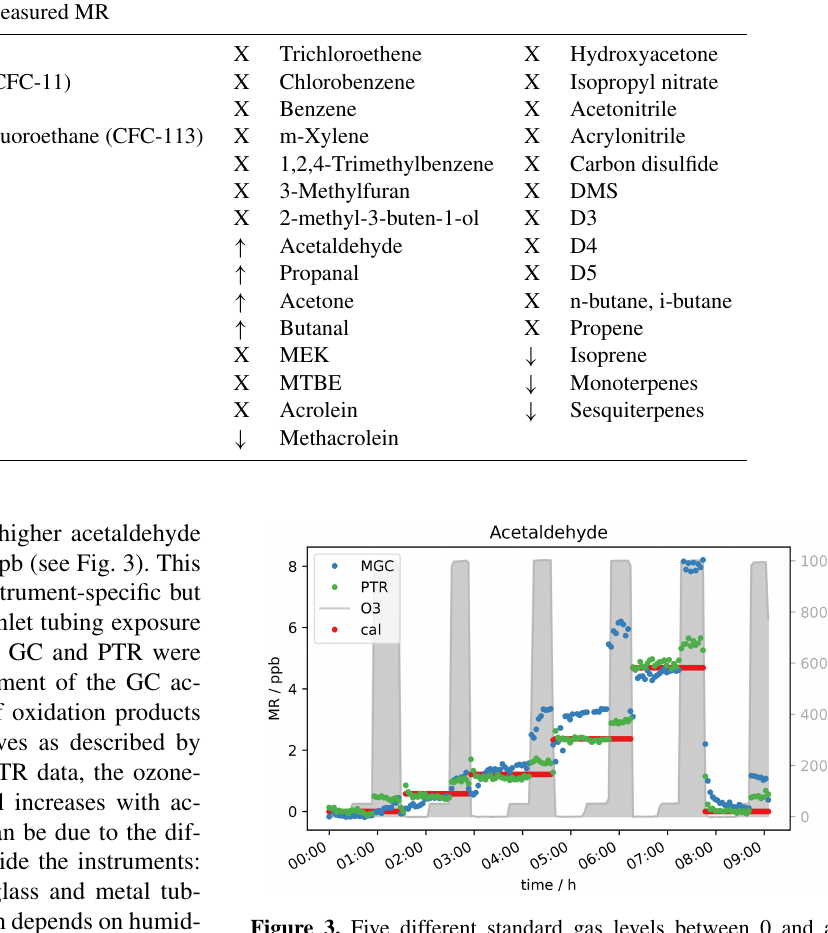
Figure 3. Five different standard gas levels between 0 and ap- prox. 4ppb at ozone mixing ratios of 0, 50 and